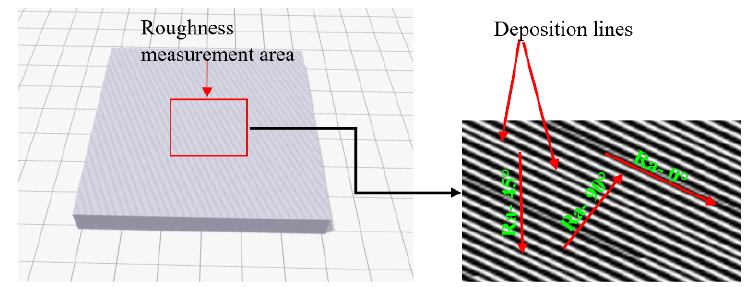
Figure 4. Roughness measurement strategy. Table 3. Surface roughness values before laser polishing.